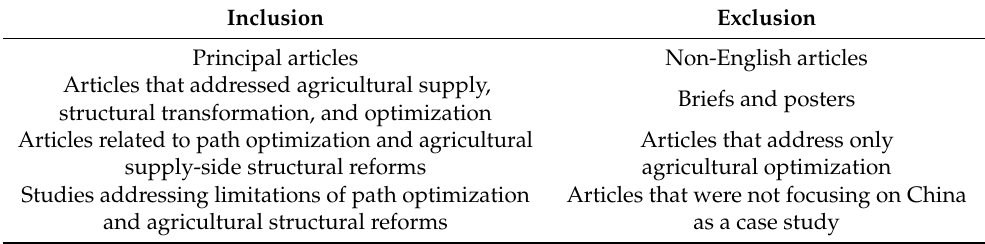
Table 2. Inclusion and exclusion